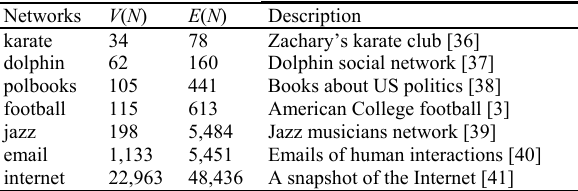
Table 1. Real-world networks used in the evaluation. Networks